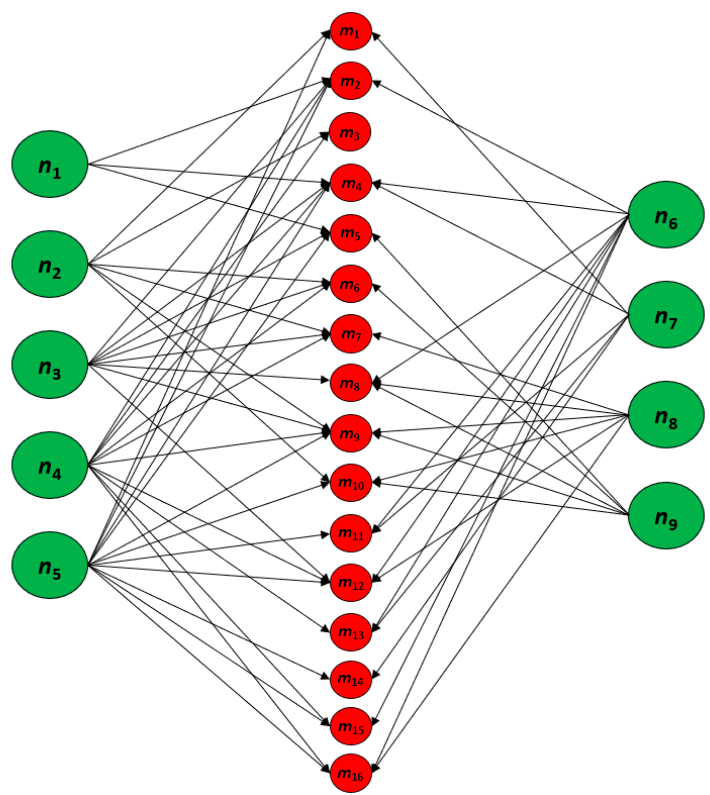
Figure 9. Graphical interpretation of the solution for Variant #3.